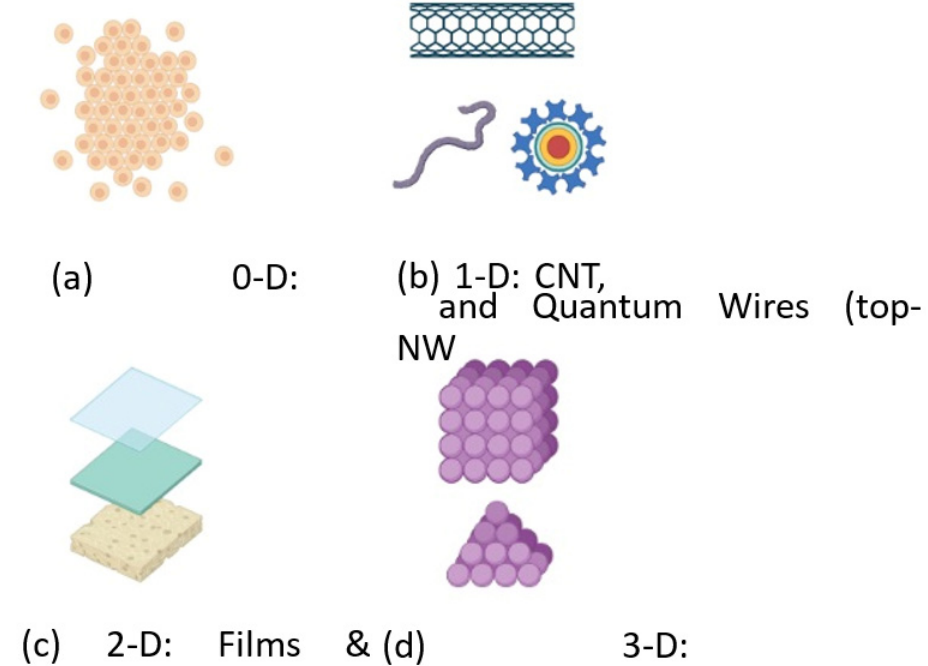
Figure 3. Nanostructures;( a ) 0 ‐ D, ( b ) 1 ‐ D, ( c ) 2 ‐ D, and ( d ) 3 ‐ D.